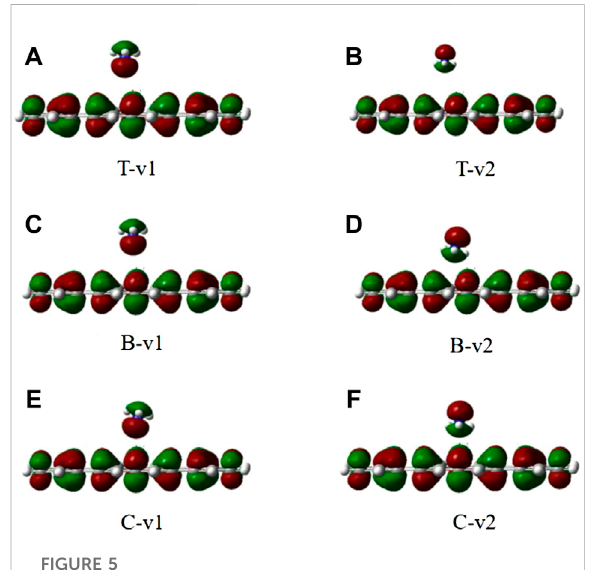
FIGURE 5 The electron density of sixdifferentcon fi gurations of NH3on the graphene-like surface. (A) : T-v1, (B) : T-v2, (C) : B-v1, (D) : B-v2, (E) : C-v1, (F) : and C-v2.